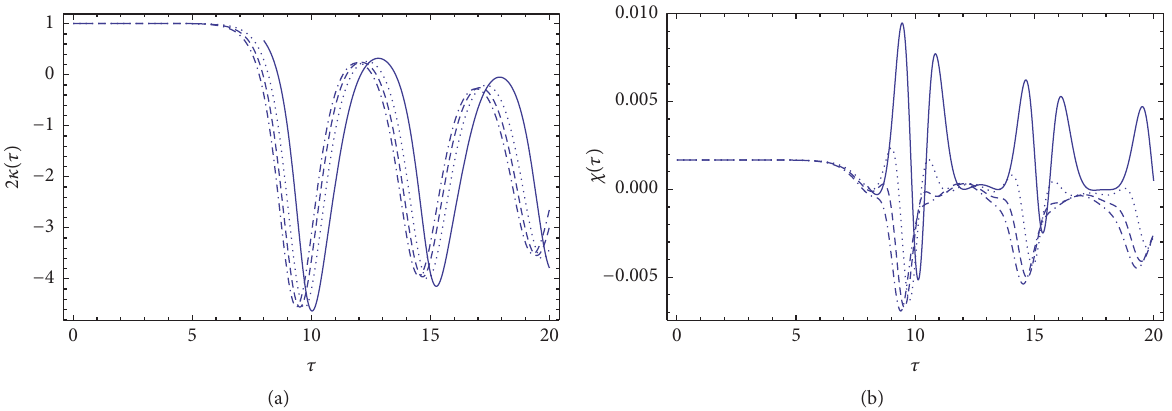
Figure 8: Time variations of the KCC invariants 2𝜅 = 𝑃 1 1 + 𝑃 2 2 (a) and 𝜒 = 𝑃 1 1 𝑃 2 2 − 𝑃 1 2 𝑃 1 2 (b) for a Universe filled with a Higgs type scalar field, for different values of the parameter 𝜂 : 𝜂 = 10 (solid curve), 𝜂 = 20 (dotted curve), 𝜂 = 30 (dashed curve), and 𝜂 = 40 (dashed dotted curve).